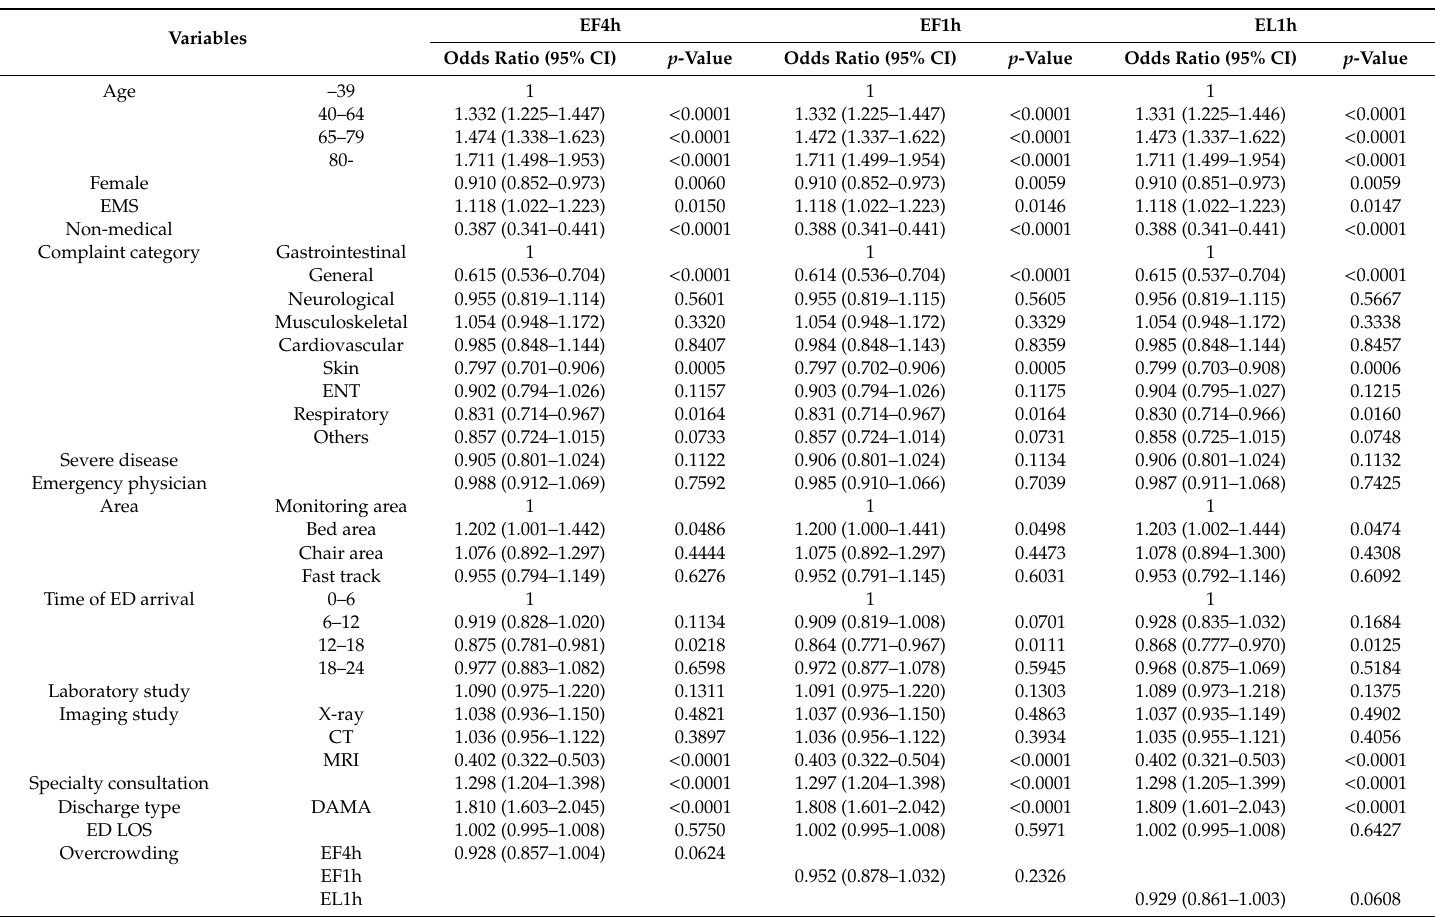
Table A3. Multivariable logistic regression of emergency department overcrowding of the number of evaluating patients for return visit within 72